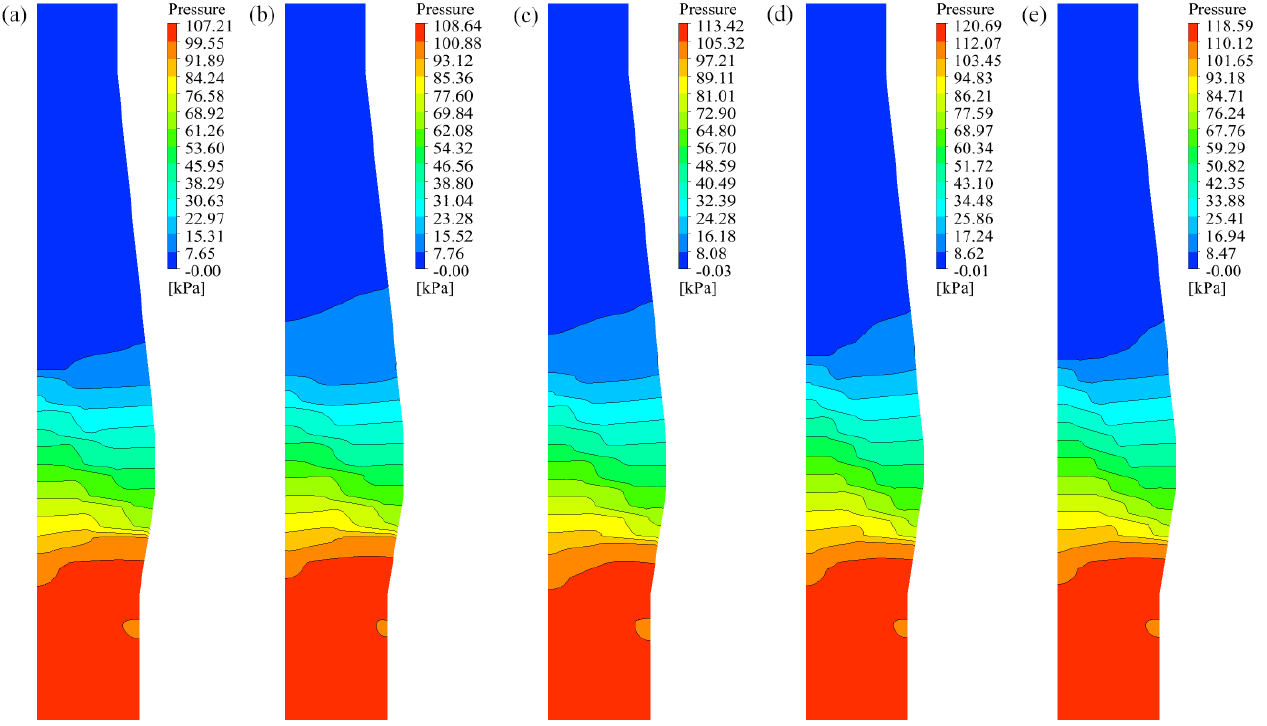
Figure 9. Pressure contours of different pre-reduction degrees ( γ = 60 ◦ ): ( a ) R = 50%, n = 6, ( b ) R = 60%, n = 6, ( c ) R = 70%, n = 7, ( d ) R = 80%, n = 8, ( e ) R = 90%, n = 9.